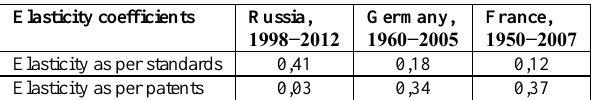
Table 1. Elasticity coefficients in relation to standards and